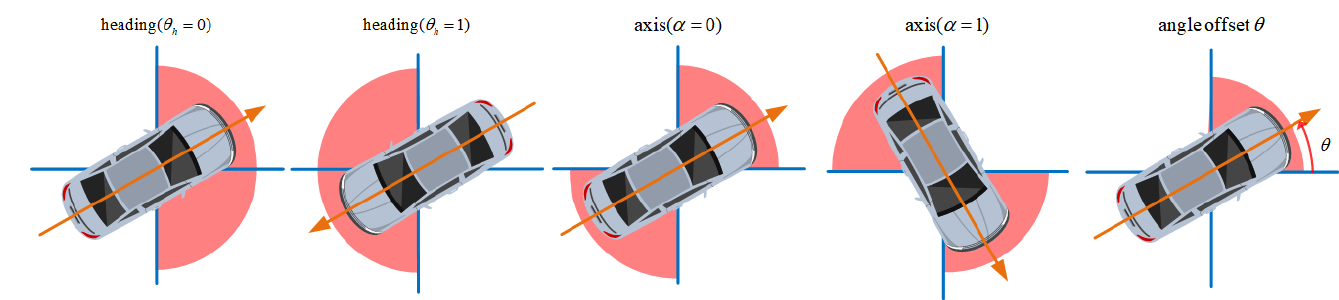
Figure 5. The decomposition of the observation angle β by the axis classification α , the heading classification θ h , and the angle offset θ